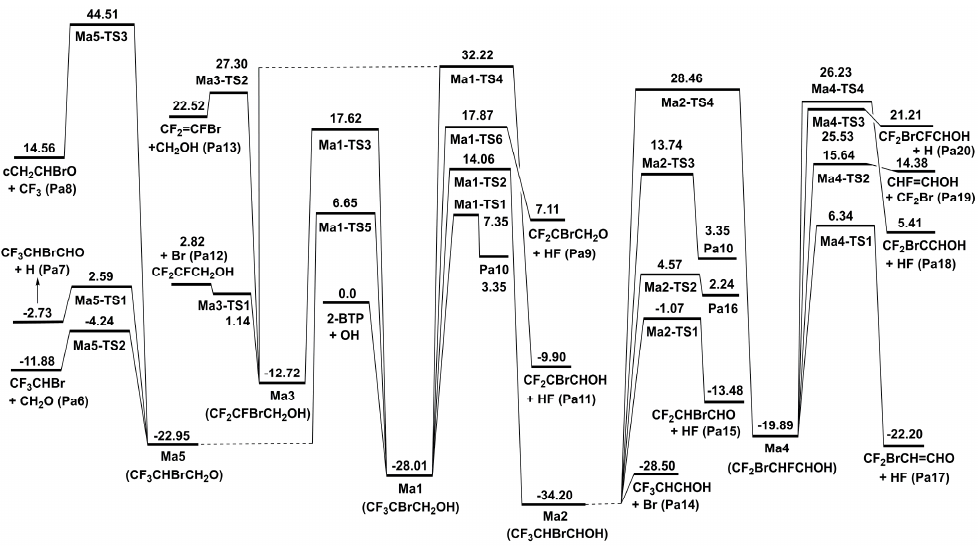
Figure 5. Schematic energy diagram of addition and eliminations for 2-BTP + OH at 0 K in kcal/mol at CCSD(T)/aug-cc-pVTZ//B3LYP/aug-cc-pVTZ (zero-point vibrational energy included).